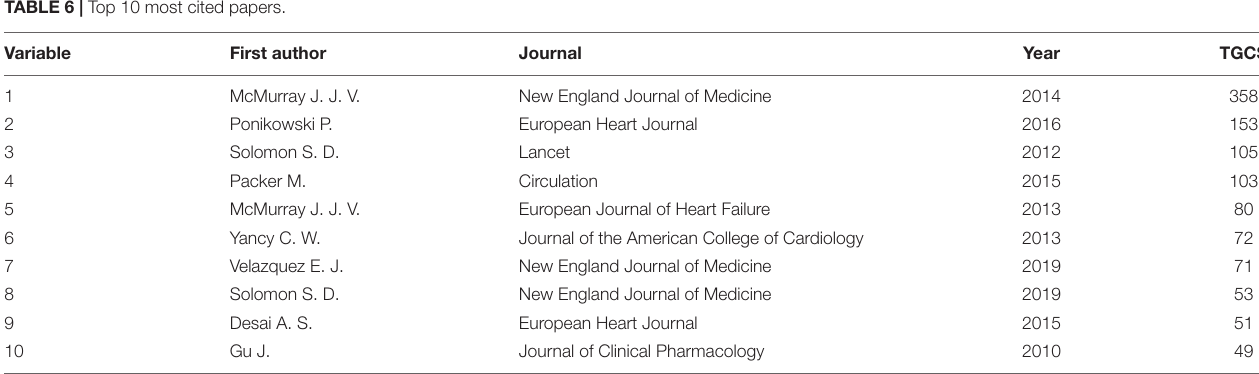
FIGURE 8 | CiteSpace visualization of the co-cited reference involved in ARNI studies in the cardiovascular system. Circle node represents reference; the line between the nodes indicates the frequency of the two references being cited at the same time. The betweenness centrality of the nodes with red circle is > 0.1. TABLE 6 | Top 10 most cited